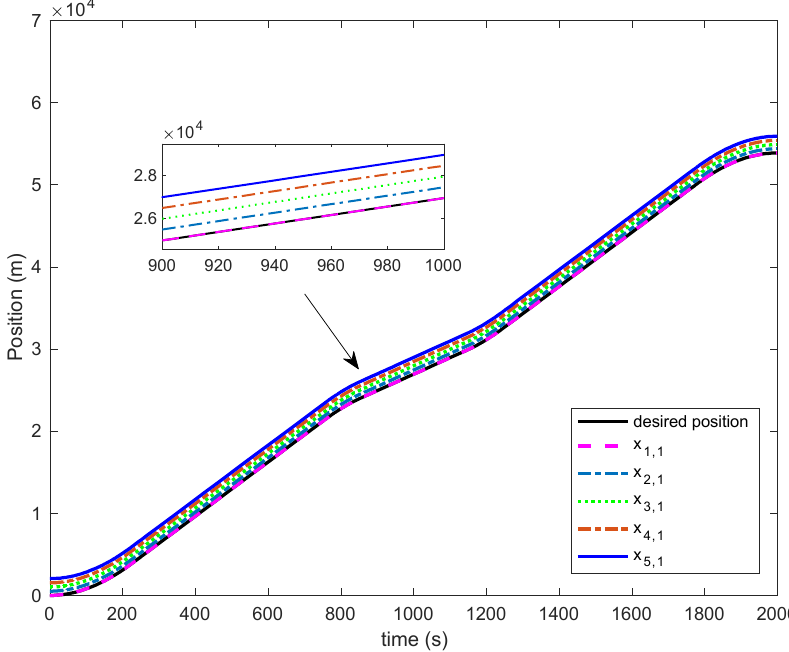
Figure 8. Desired position and position tracking curves for single-value learning.